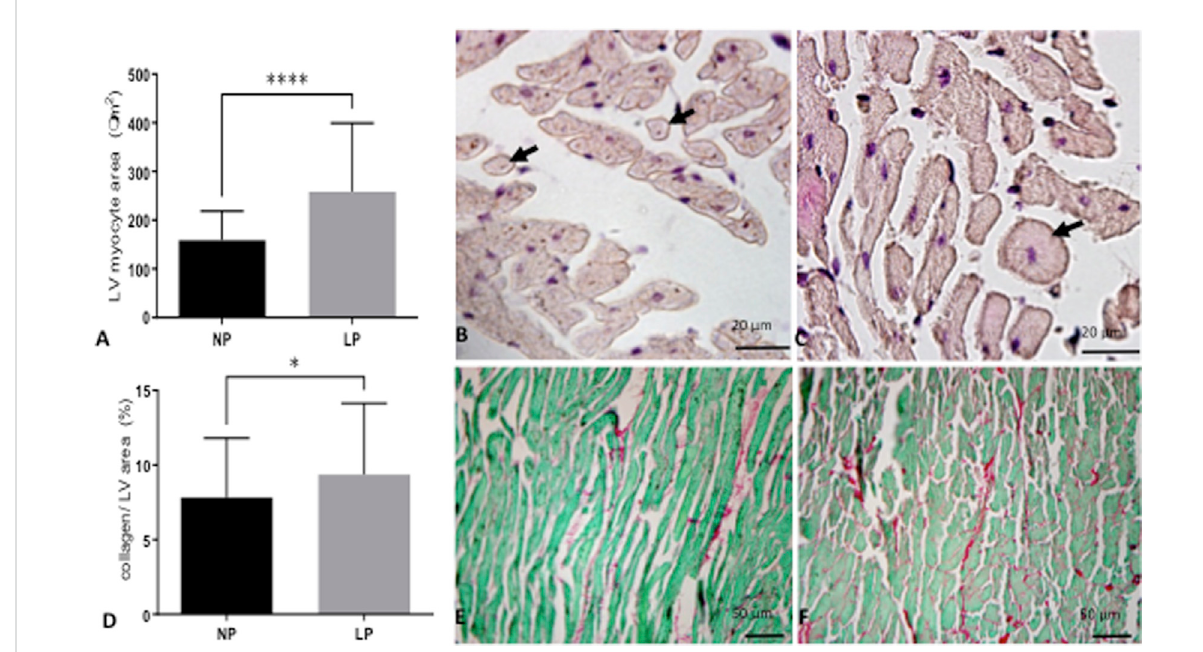
FIGURE 2 In A, a graphic of LV cardiomyocytes (arrow) area (NP: 174 fi elds; LP: 199 fi elds from n = 5) and representative micrographs of NP offspring (B) and age-matched LP progeny (C) LV tissue stained with hematoxylin-eosin (HE). In D, depicted LV collagen content (100 fi elds for each group from n = 5) and picrosirius fast green stained LV tissue from NP (E) and LP (F) offspring. The results were expressed as mean ± SD, and Student ’ s t-test performed the statistical analysis. * p < 0.05, **** p < 0.0001.